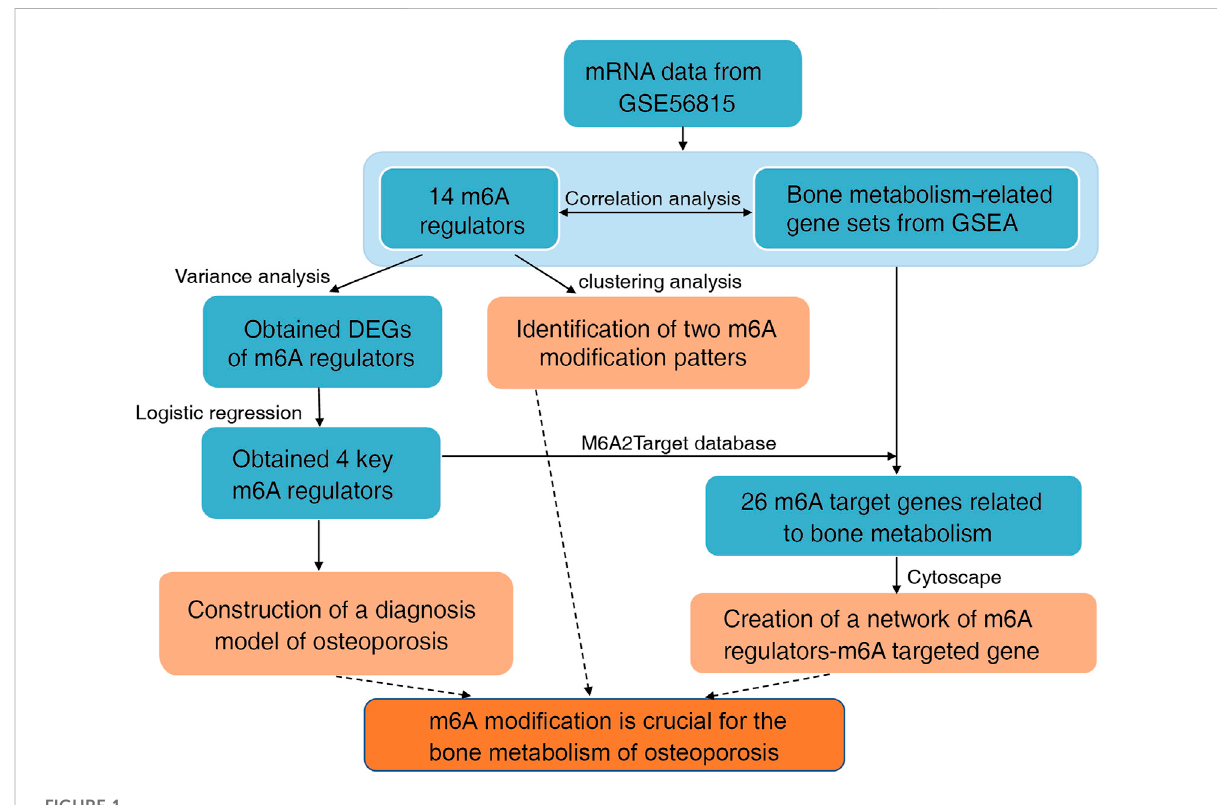
Flowchart and analysis strategy used in this